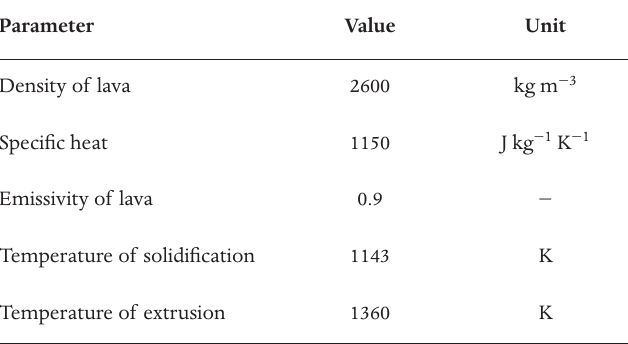
Table 1. Typical parameters for Mount Etna lava